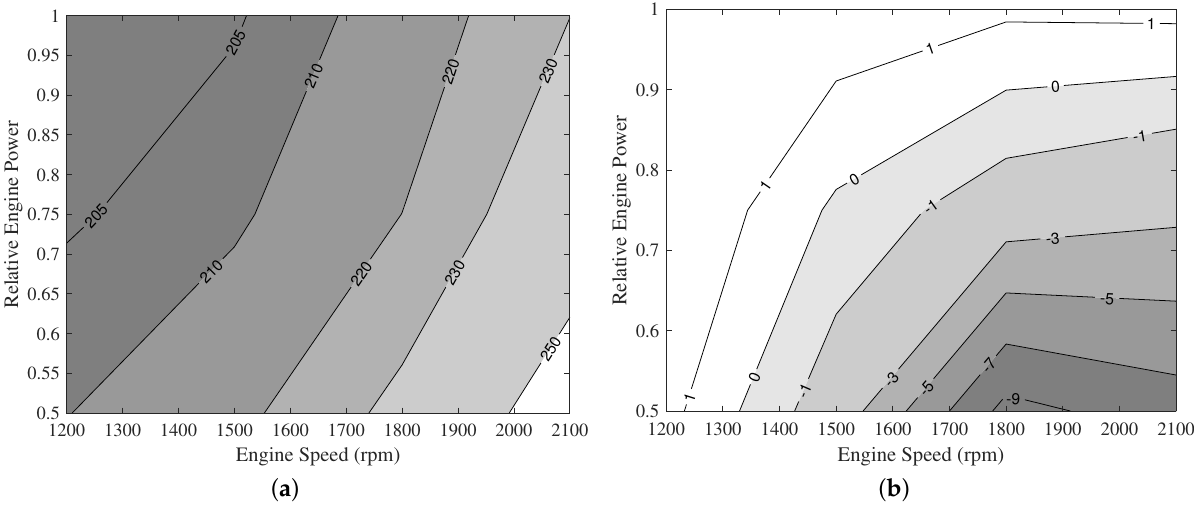
Figure 7. Results obtained from SCANIA DC 09 engine model. ( a ) Specific fuel consumption (g/kWh) map calculated by model. ( b ) Percentage differences between calculated and measured values of b e